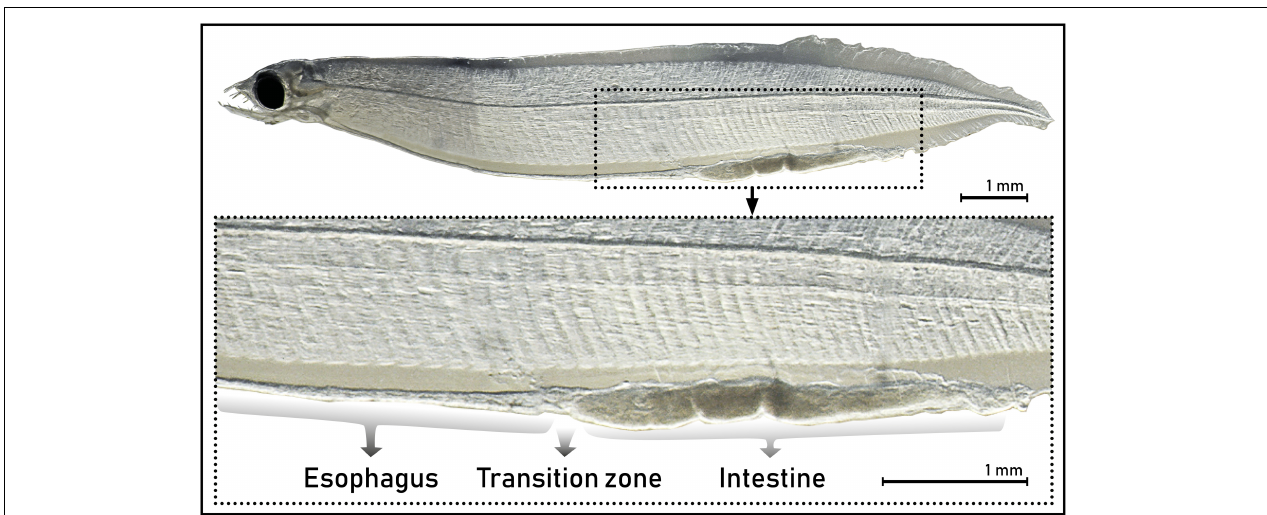
FIGURE 2 | External appearance of the digestive tract of leptocephalus larvae of the European eel ( Anguilla anguilla ) (L10, SL 11.17) showing the difference between the two areas of the digestive tract, the esophagus and the intestine, and the transition zone between these.